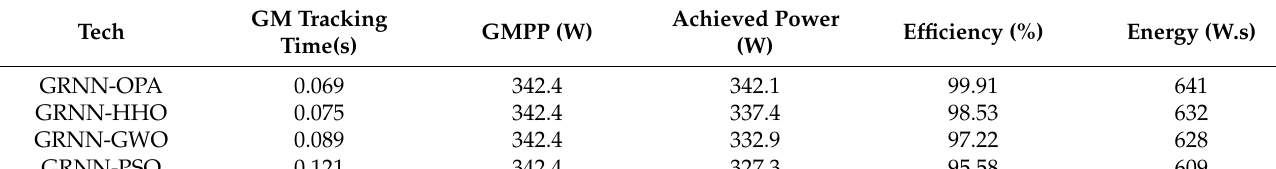
Figure 11. Comparison of duty cycle variation in case 2. The results in Figures 10 and 11 show that GRNN-OPA has the shortest TT of 69 ms with a corresponding ST of 110 ms. The detailed comparison is shown in Table 2. The standard PSO takes 121 ms to track GM in fast-varying temperatures and causes loss of power due to random oscillations. Under NUTD conditions, the LM trap becomes predominant and is a major cause of power loss. The GRNN-OPA, GRNN-HHO, and GRNN-PSO have TT of 75 ms, 89 ms, and 121 ms. The extracted energy comparison is shown in Figure 12. Table 2. Comparison of results for case 2.